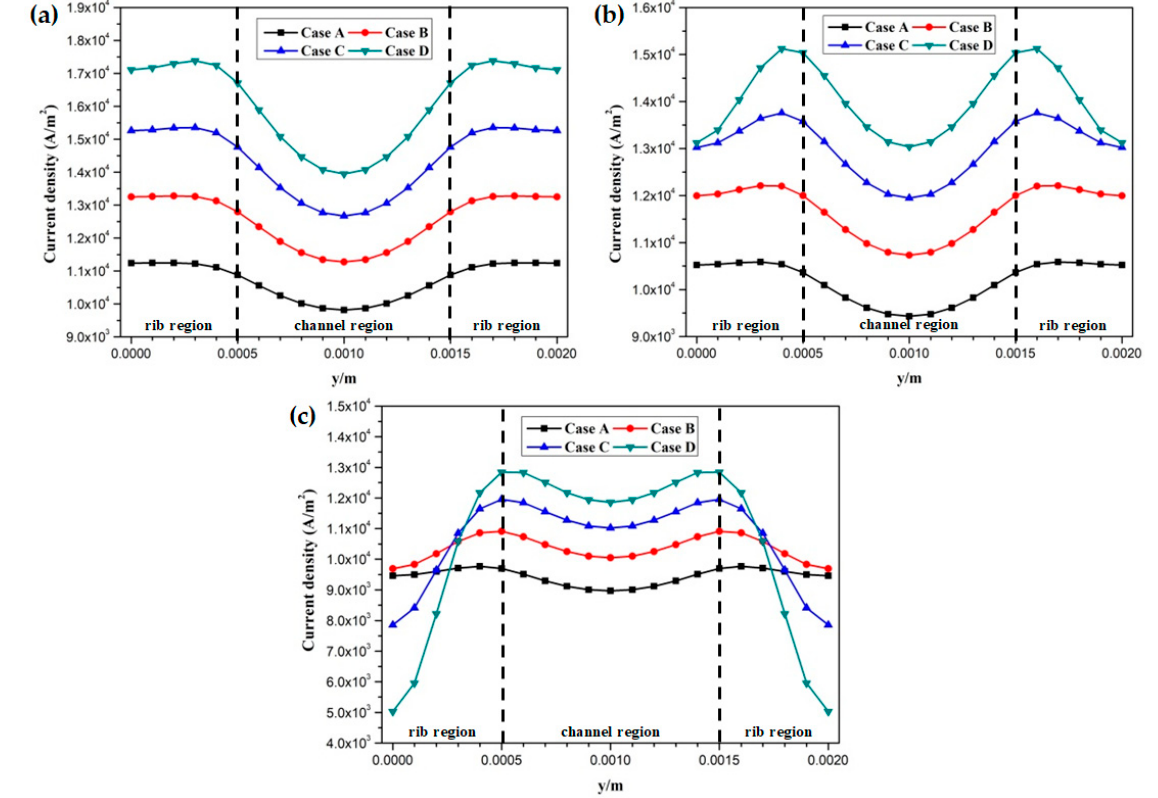
Figure 10. Local current density distribution of fuel cells at the middle plane of membrane (Case A: DL = 5; Case B: DL = 7; Case C: DL = 9; Case D: DL = 11): ( a ) x = 0.005 m; ( b ) x = 0.025 m; ( c ) x = 0.045 m.